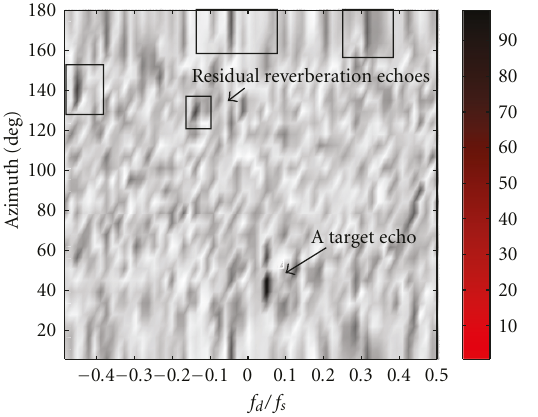
Figure 9: PCI output with the three-mode array.